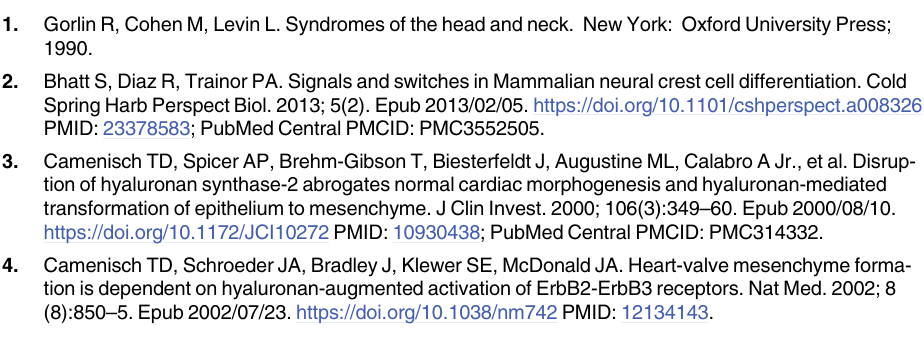
S1 Table. Primer sequences for PCR genotyping of mice. S2 Table. Sequences of crRNA and the inserted FLAG-encoding DNA fragment used for the creation of the Tmem2-FLAG knock-in allele ( Tmem2-FLAG KI ). S3 Table. Primer sequences for qPCR analysis of